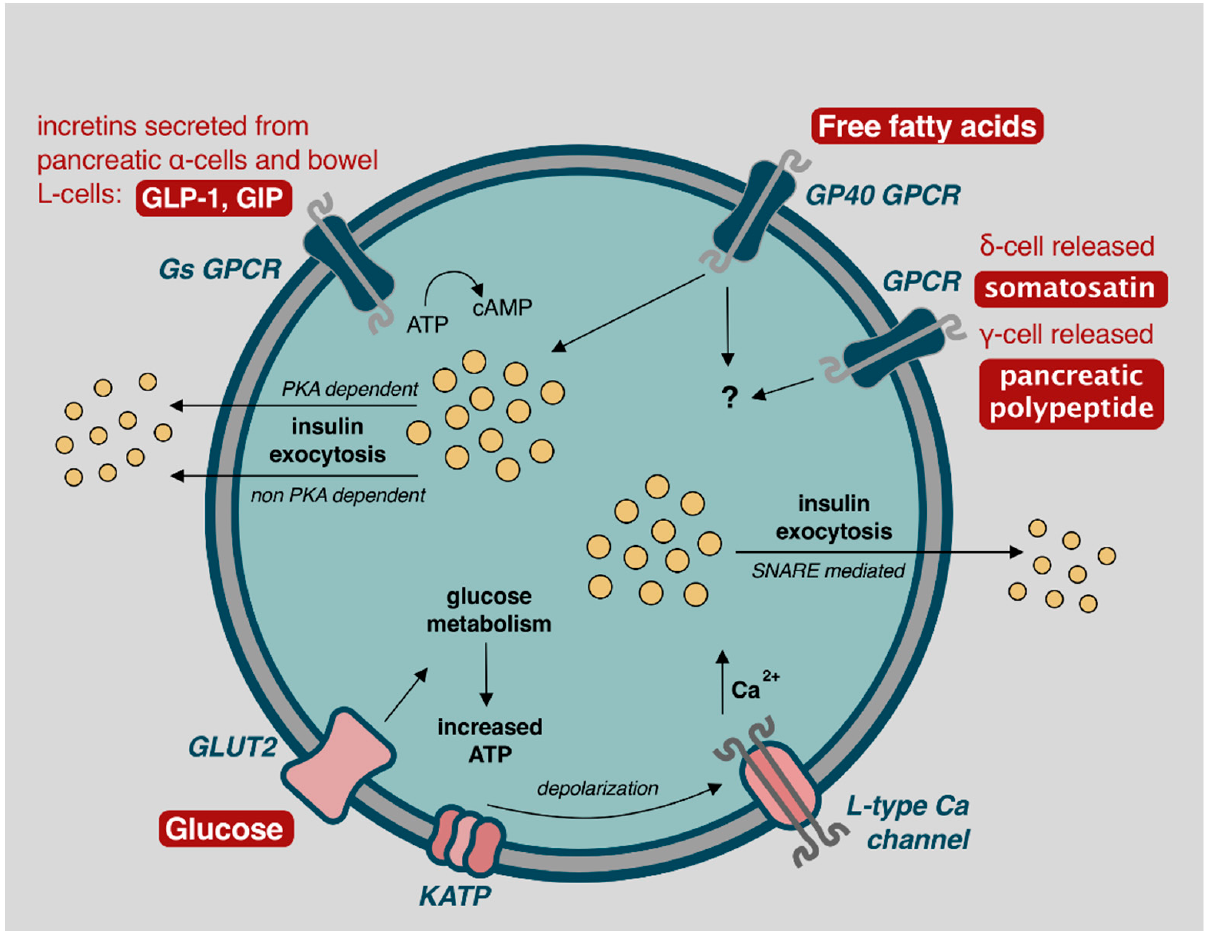
Figure 2. Mechanisms of β -cell insulin release and glycemic control. Image adapted from Komatsu et al. (2013) with permission for reuse [56].